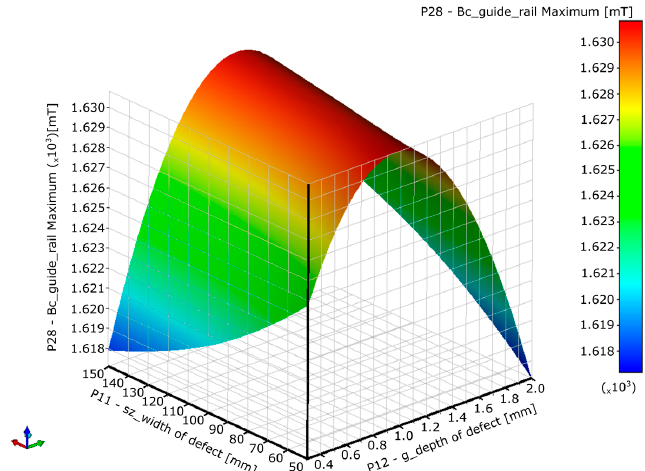
Figure 10. 3D plot showing the impact of width “ sz ” and depth “ g ” of defects onto the maximum value of total induction in the guide rail.